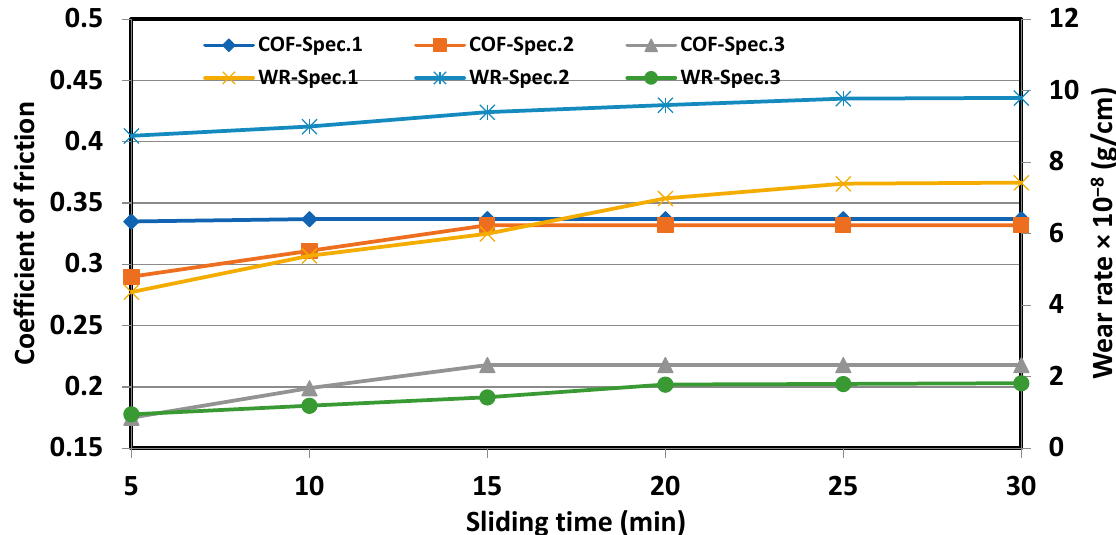
Figure 6. Differences in the friction coefficients and wear rates based on sliding time.